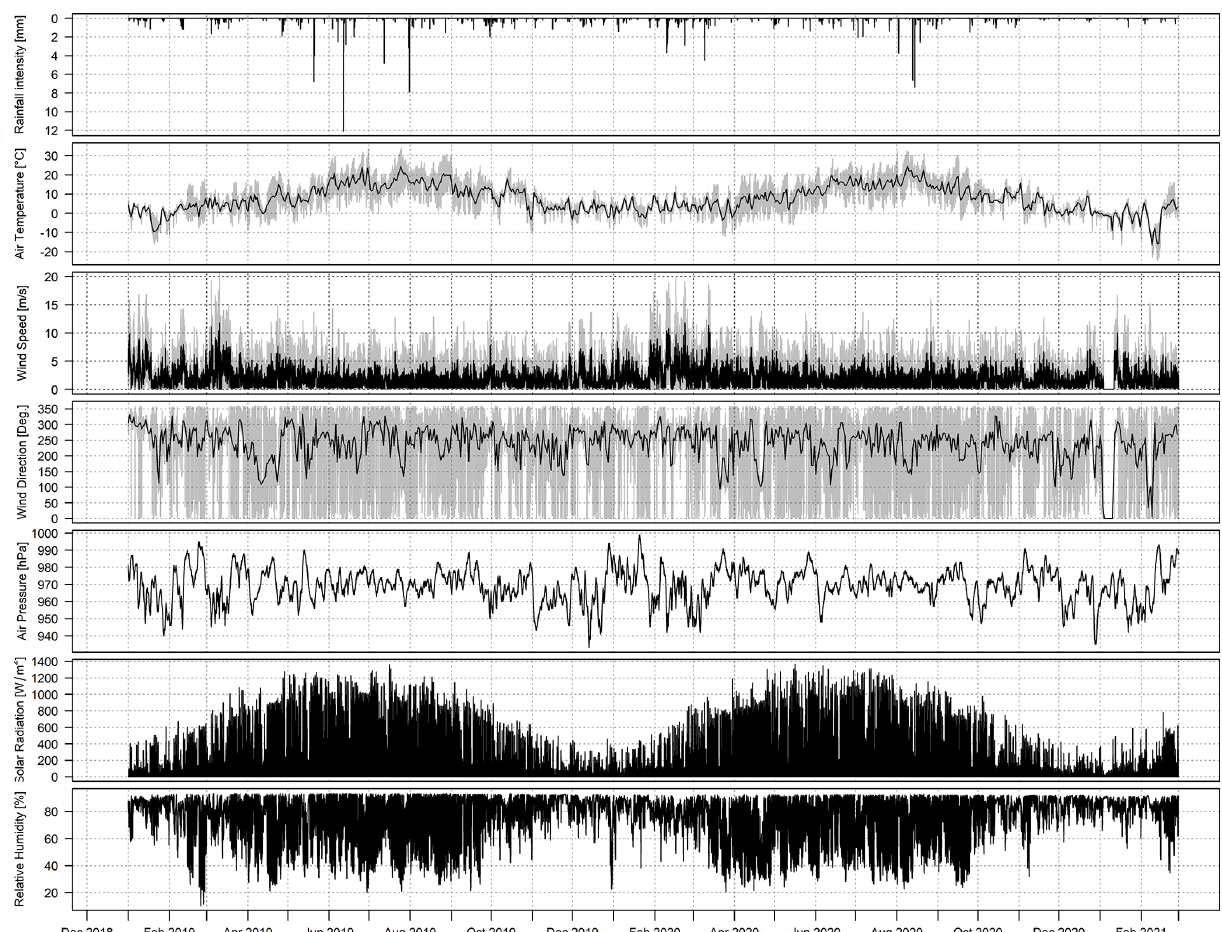
Figure 7. Time series of all the meteorological variables measured at the Schäfertal Hillslope site. The plots were made using the data set as it appears in the online archive. The black line in the second, third, and fourth plots shows the daily average temperature, the average wind speed, and the daily average wind direction, respectively, while all other data are in 10min time